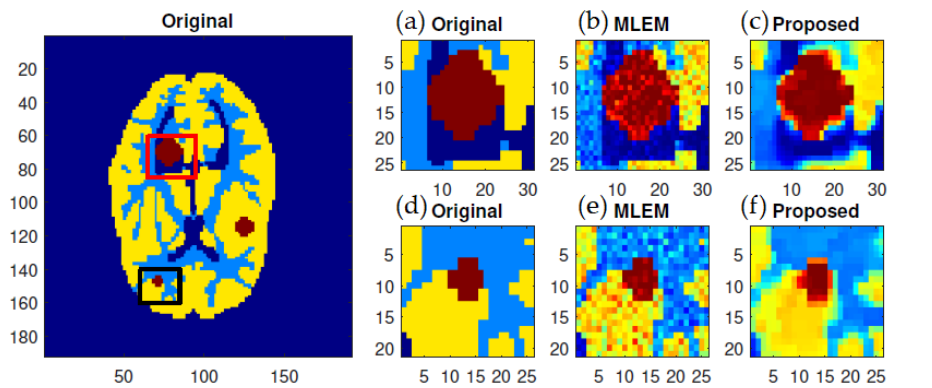
Figure 6. ROIs of Huffman Brain Phantom reconstruction achieved using various algorithms as shown under magnification: ( a , d ) the ground truth; ( b , e ) MLEM; and ( c , f ) f -MLEM.